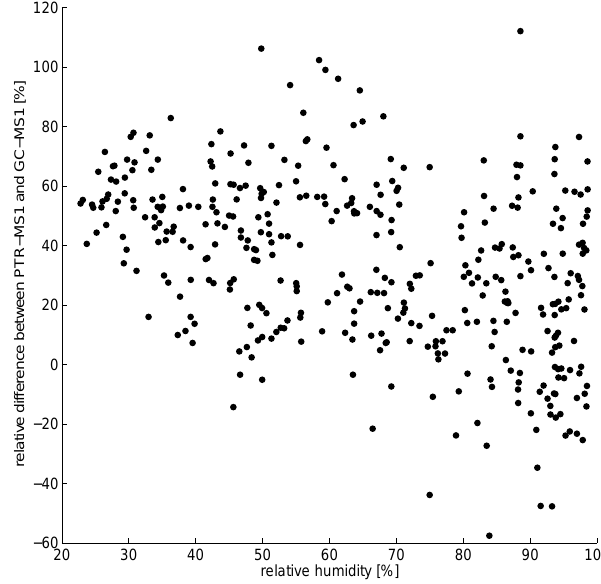
Figure 6. Relative difference of the methanol measurements with PTR-MS1 and GC-MS1 against